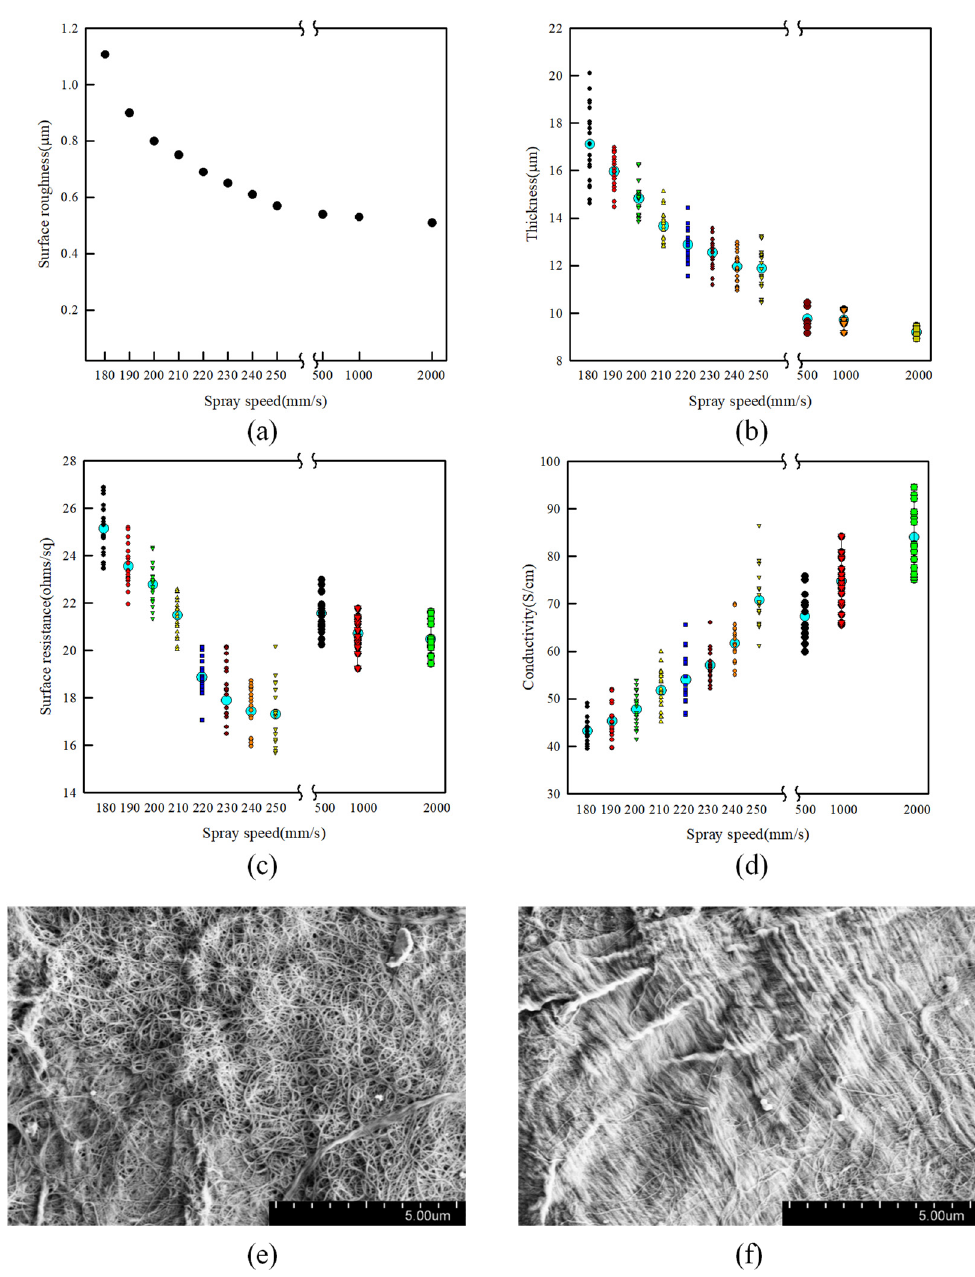
Figure 5. Total properties by controlling spray speed ( a ) surface roughness, ( b ) thickness, ( c ) surface resistance, ( d ) conductivity, and scanning electron microscope (SEM) images of sprayed film at speeds of ( e ) 200 mm/s and ( f ) 2000 mm/s by controlling spray speed.